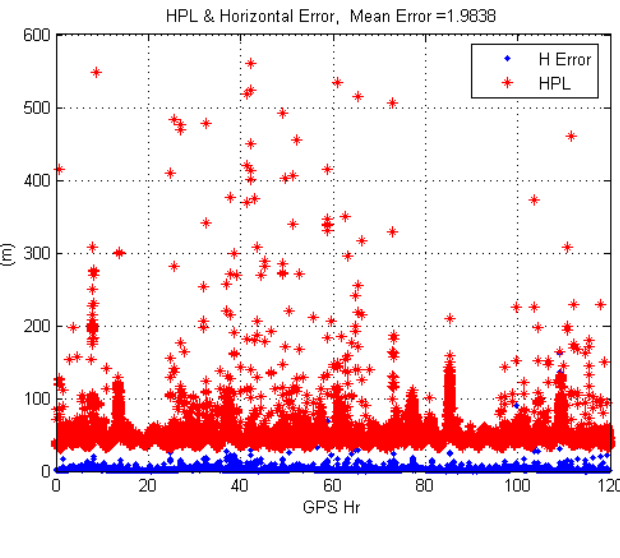
Figure 26. The HPL and horizontal position error in Taipei FIR (4